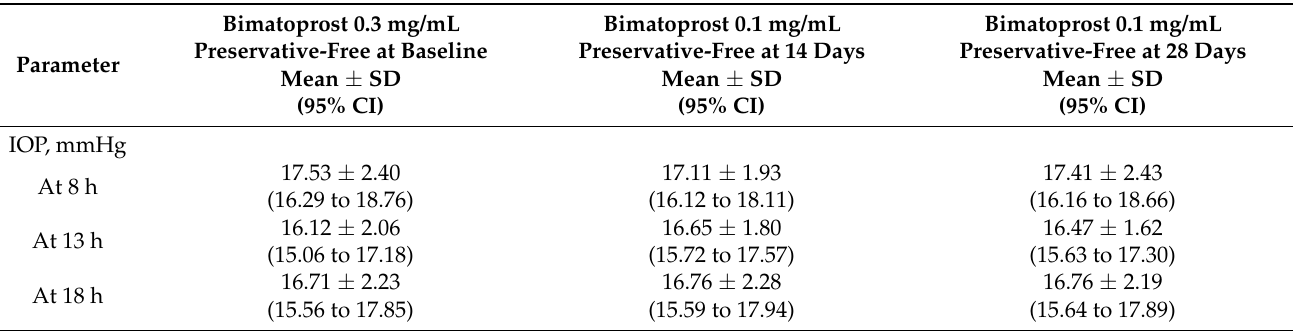
Table 5. Comparisons between the treatments and the intraocular pressure measurements at 8, 13, and 18 h.